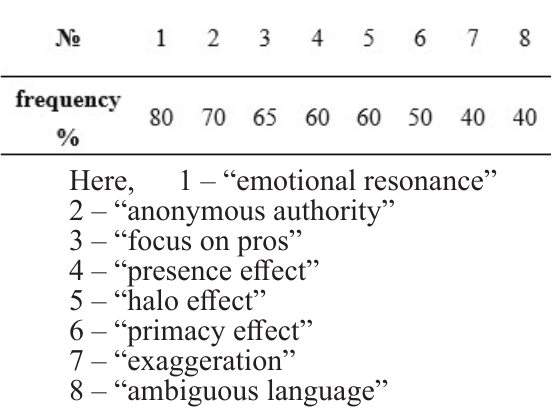
Table 1. Eight main types of